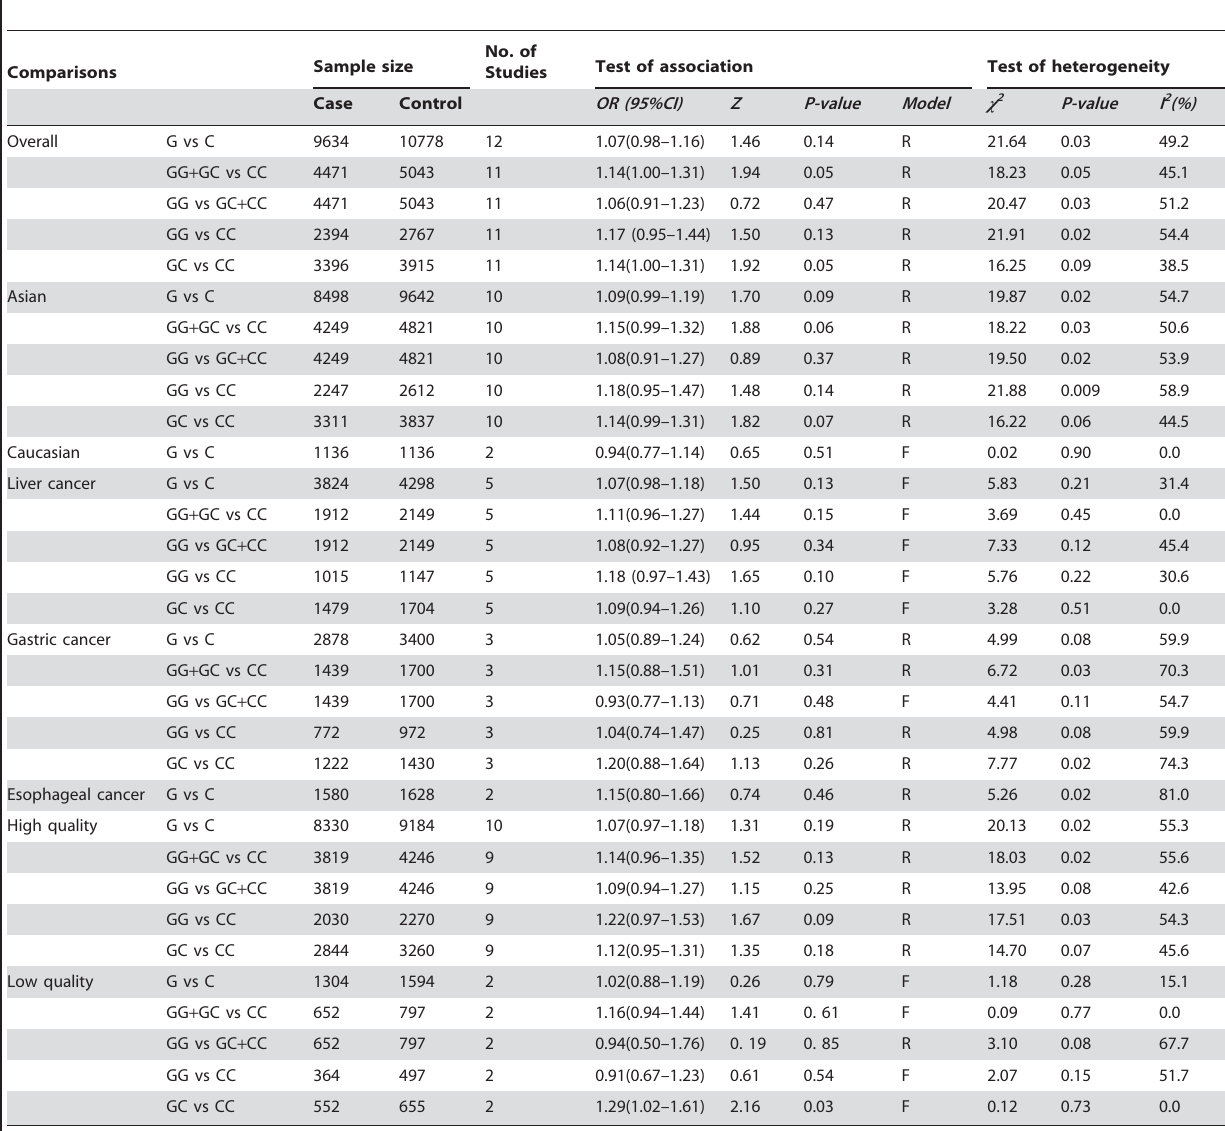
Table 3. Meta-analysis of miR-146a rs2910164 polymorphism with gastrointestinal cancers.*